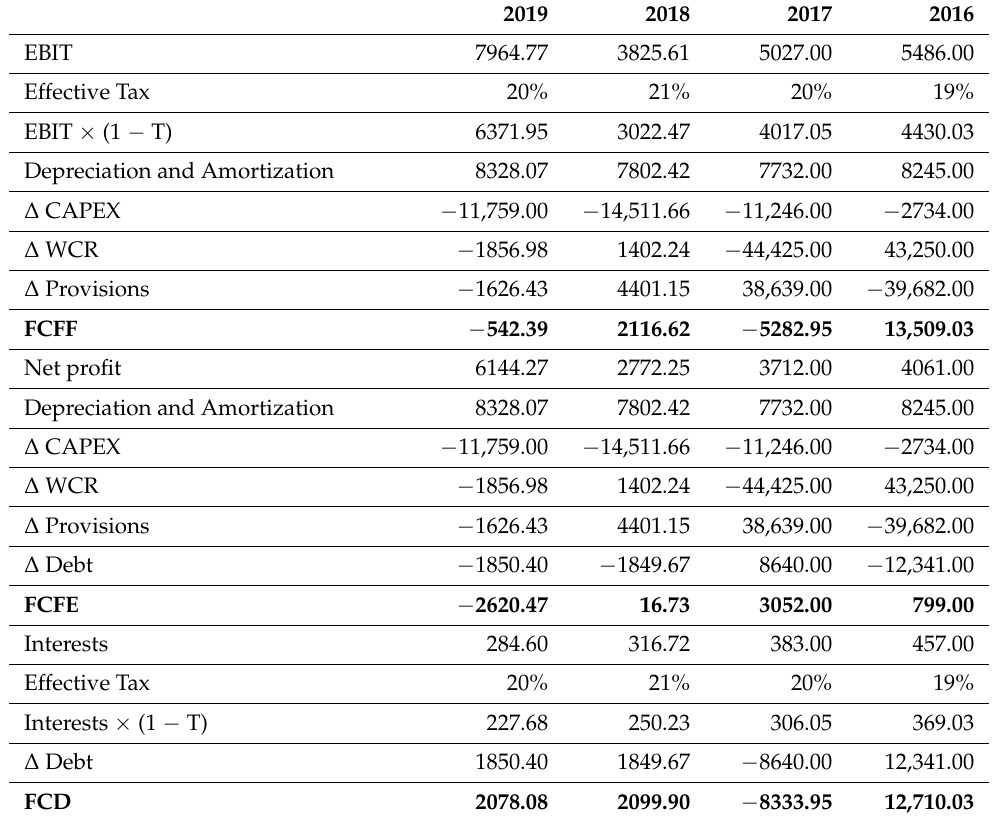
Table 4. Shaping of FCFF, FCFE and FCD flows and the components affecting them in PEC Geotermia Podhala´nska S.A. (PLN